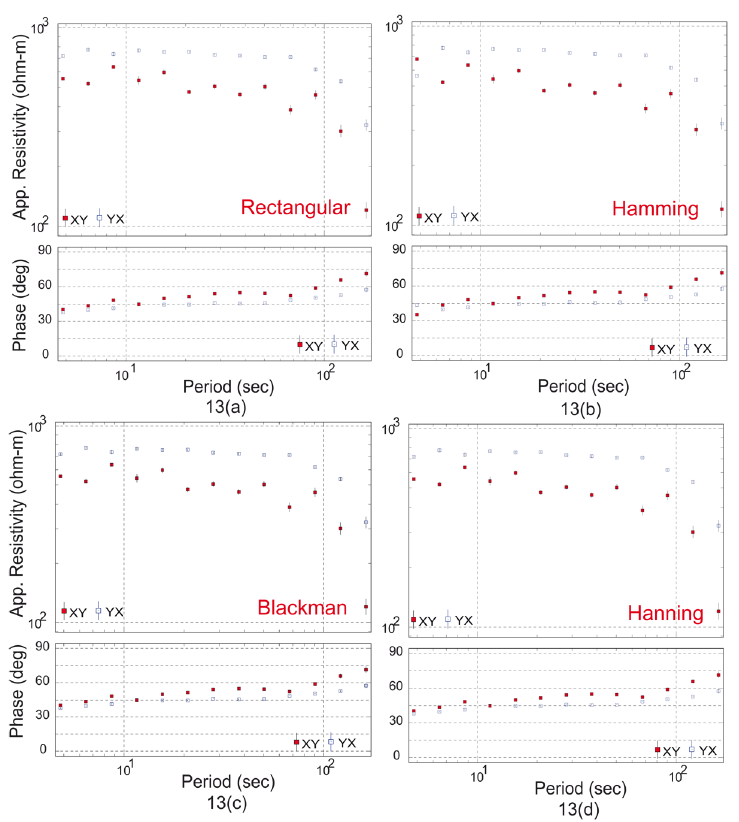
Figure 13. Result obtained after windowing with a fixed window length of 1024 from different window functions on 1 Hz data of Remote Site A28. (a) Apparent resistivity (upper panel) and phase (lower panel) curves obtained using Rectangular window. (b) Apparent resistivity (top panel) and phase (bottom panel) curves obtained applying Hamming window. (c) Apparent resistivity (top panel) and phase (bottom panel) curves obtained from Blackman window. (d) Apparent resistivity (upper panel) and phase (lower panel) curves obtained using Han- ning window. All the windows have almost similar outcome. The red colored boxes represent XY components and the blue colored boxes represent YX components of apparent resistivity and